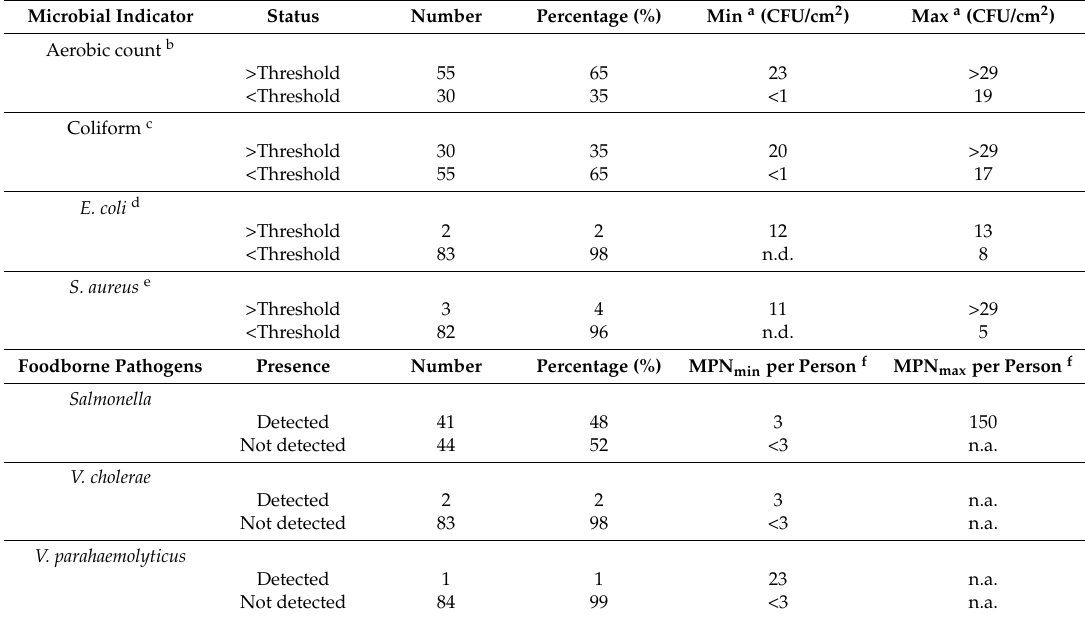
Table 5. Performance of participants’ hand hygiene based on aerobic bacteria, coliforms and E . coli , S . aureus count and the detection of Salmonella , V. cholerae and V. parahaemolyticus . Microbial